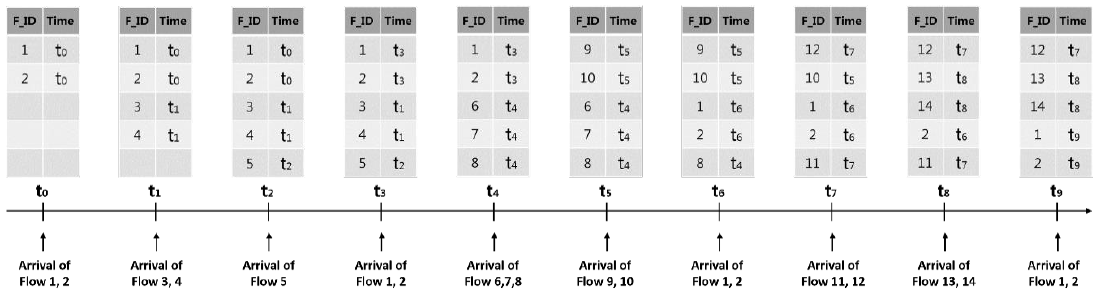
Figure 6. An example of updating the flow table using the Least Recently Used (LRU) scheme.